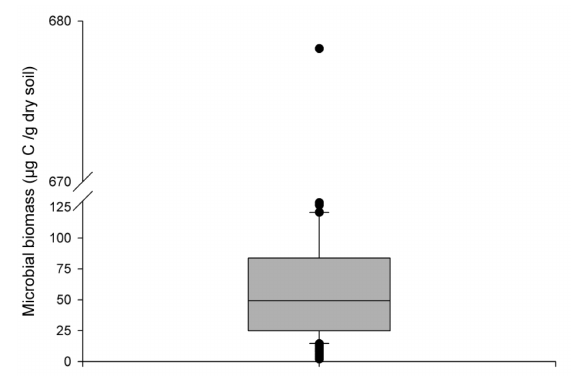
Figure 10. Box plot of 206 observations of microbial biomass of soils under Eucalyptus growing in southeast Brazil (0–10cm depth) (Marcos Rogério Tótola, personal communication,